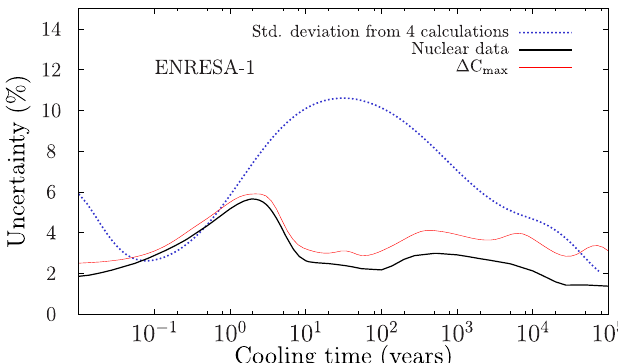
Fig. 4. Calculated uncertainties (from nuclear data and total uncertainties) and standard deviation for the 4 decay heat calculations for the segment containing sample